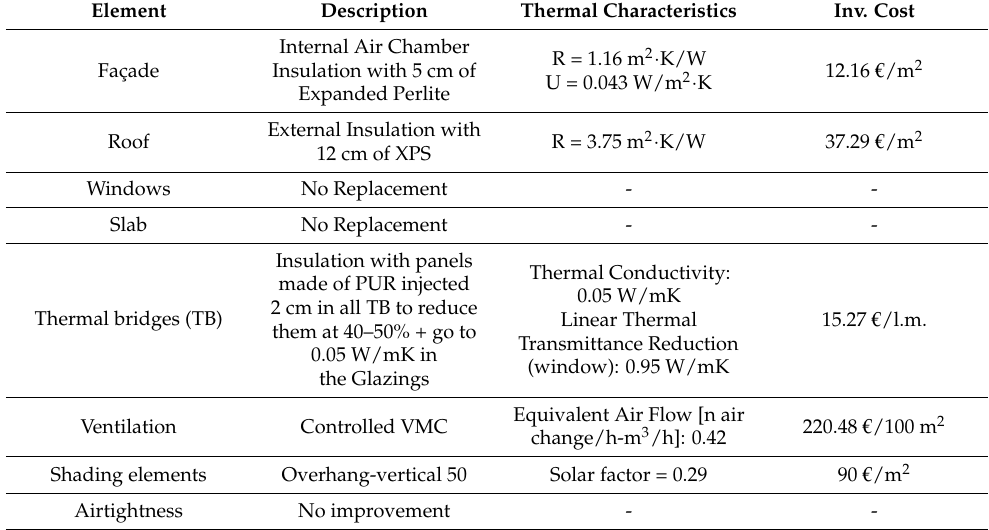
Table A1. POS1s: Renovation measures of solution 6.